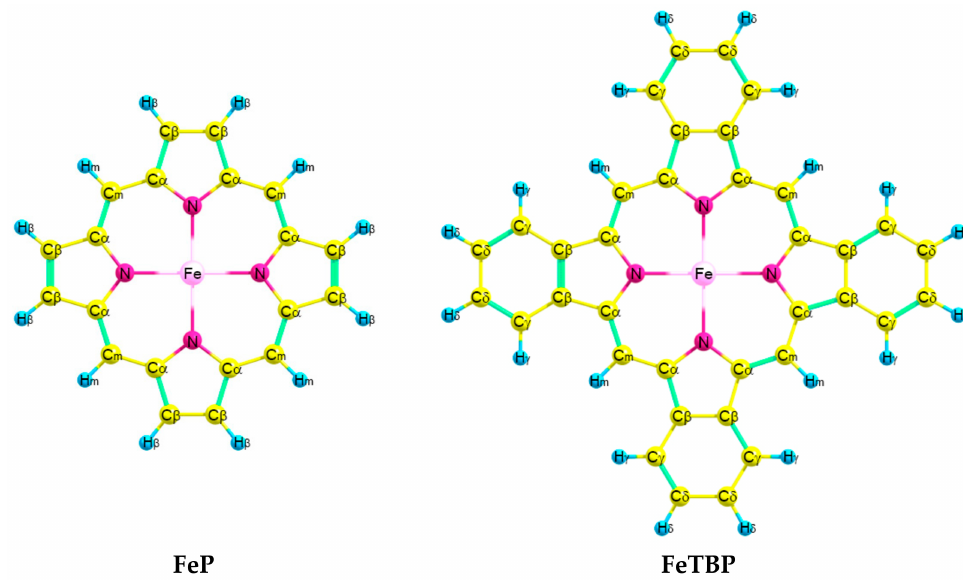
Figure 1. Molecular models of FeP and FeTBP with atom labeling.